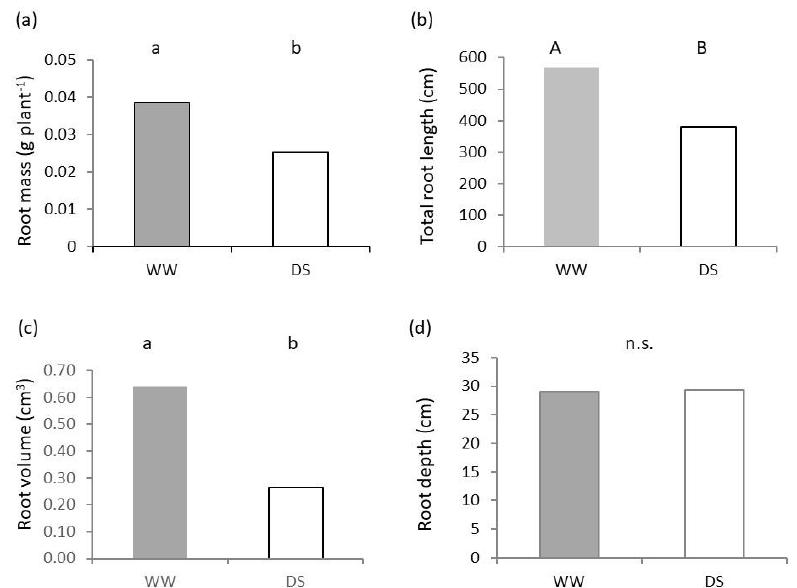
Figure 3. Root growth and architecture of seedlings of Saragolle lucana under different soil water availability. ( a ) Root dry mass; ( b ) total length of root structures; ( c ) total volume of root structures; and ( d ) root depth. Different letters on each bar designate significantly different values at the Tukey’s post hoc mean separation test for p < 0.05 (lowercase letters) or p < 0.01 (uppercase letters), or non-significant differences (n.s.) for p > 0.05.